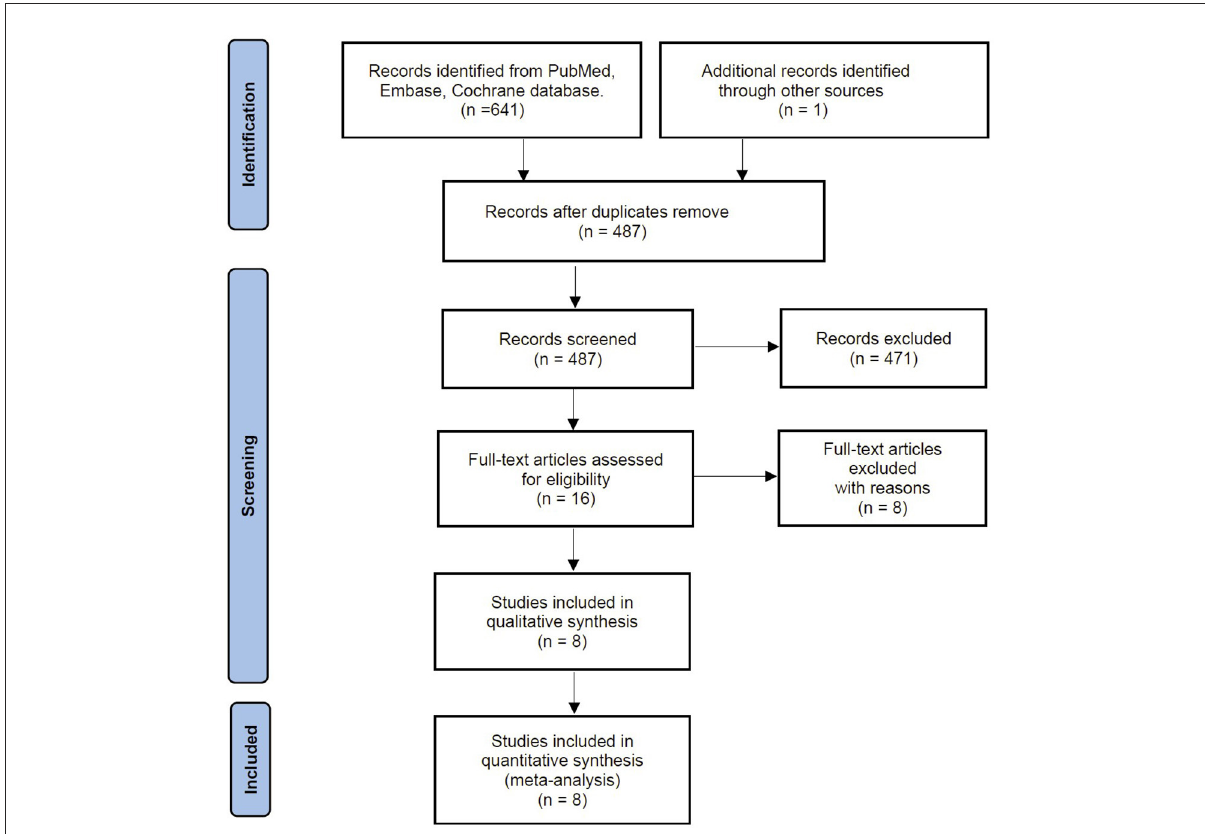
FIGURE1 Flow chart of literature